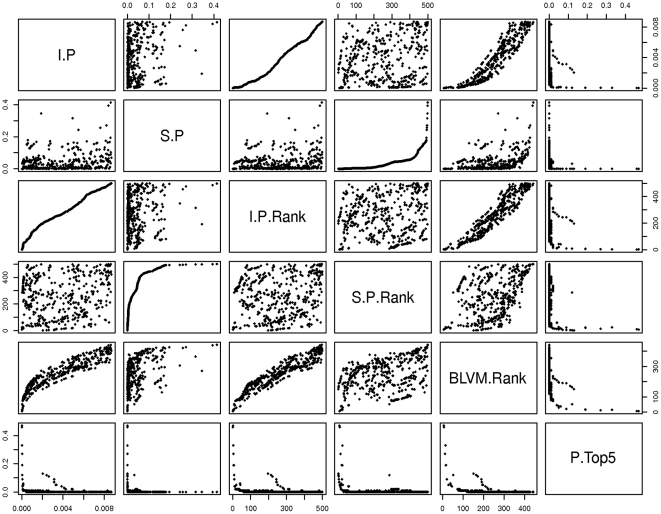
Relationship between SNP association p-values, rankings based on p-values and BLVM and Probability in the top 5 markers.I.P and S.P represent the p-values from the analyses involving all invasive cases or invasive serous cases, respectively; I.P.Rank and S.P.Rank represent the rank of the marker based on the p-values from the analysis involving all invasive cases or invasive serous cases, respectively; BLVM.Rank and P.Top5 represent the median rank and the probability of being in the top 5 markers based on the BLVM.